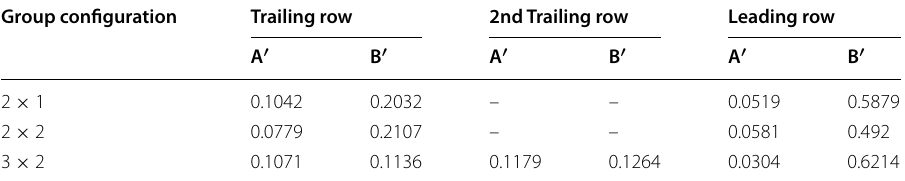
Table 4 Values of C and D constants for both cohesionless and cohesive soil Group